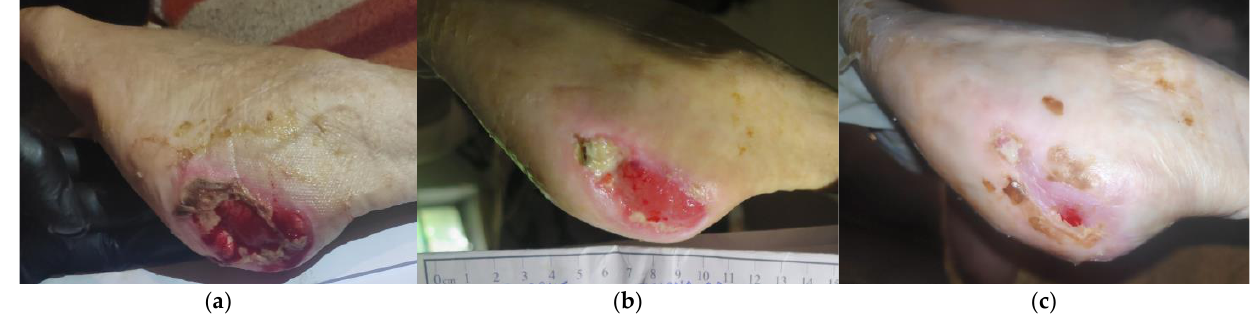
Figure 2. Case 2: ( a ) clinical findings at the initial examination, day 0 (start of MGH treatment); ( b ) reduction of the wound size with marginal re-epithelialization and granulation tissue formation after three weeks of MGH therapy; ( c ) complete wound healing after 12 weeks of MGH therapy.